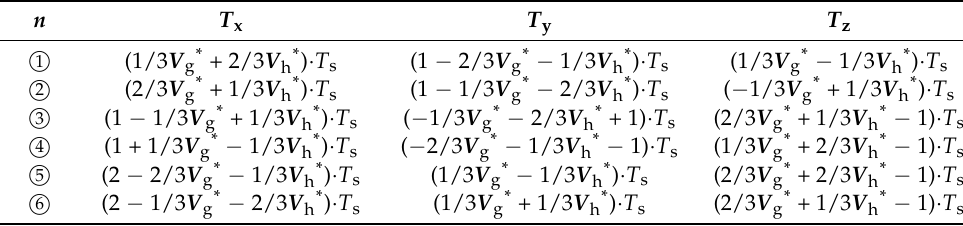
Figure 8. The sector division of 0CMV-SVPWM. 3.4. The Algorithm of MMC Capacitor Voltage Balancing The MMC obtains the number of input-SMs N onp,n x for each bridge arm of the three phases through SVPWM modulation of two bridge arms. The different input times of the SMs cause imbalances in charging and discharging. It is necessary to adopt the appropri- ate capacitance voltage balancing algorithm so that the SM’s capacitance voltage is kept near the rated value of V dc /4 during the operation of the MMC. Currently, the two most widely used balancing algorithms are the closed-loop capacitor voltage balancing algo- rithm based on PWM and the capacitor voltage sorting balancing algorithm. Because the sorting algorithm has easy implementation, good flexibility, and adaptability in the mod- ulation strategy, it is adopted in this paper as the capacitor voltage balancing algorithm. At every control period T s , the capacitance voltage values of each sub-module are sampled and sorted. First, if the bridge arm current direction is positive, the SM with the lower capacitance voltage is selected in sequence and put into priority to charge it and increase